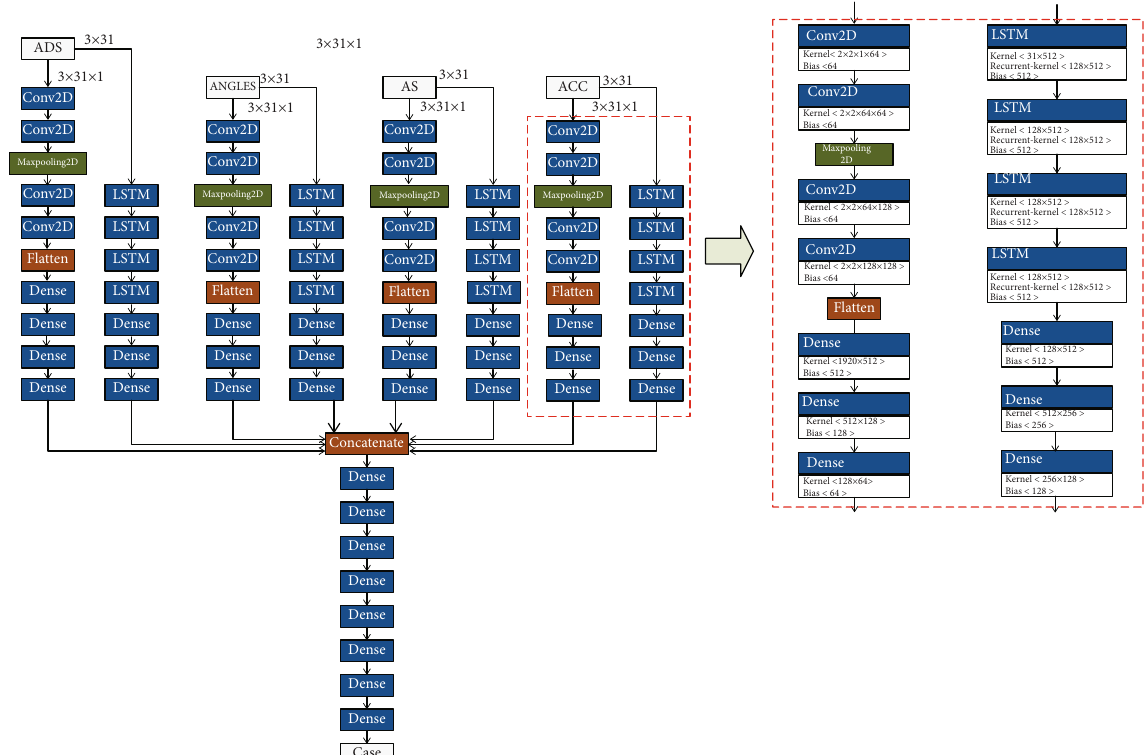
Figure 4: Full architecture of the IMU fault detection network. (a) DNN-FULL architecture. ADS: airspeed, AOA, and sideslip angle measured by air data sensors; ANGLES: Euler angles; AS: angular speeds; ACC: accelerations; Conv2D: convolution layer; Dense: fully connected layer. 2 × 2 kernels are also used in Maxpool layers. Flatten layers reshape 2D data to 1D for Dense layers. Concatenate layer merges all the data from previous layers. (b) Detailed con fi gurations of CNN and LSTM modules in acceleration channel, kernel size, and bias are depicted. Con fi gurations of other channels are the same as those of the acceleration